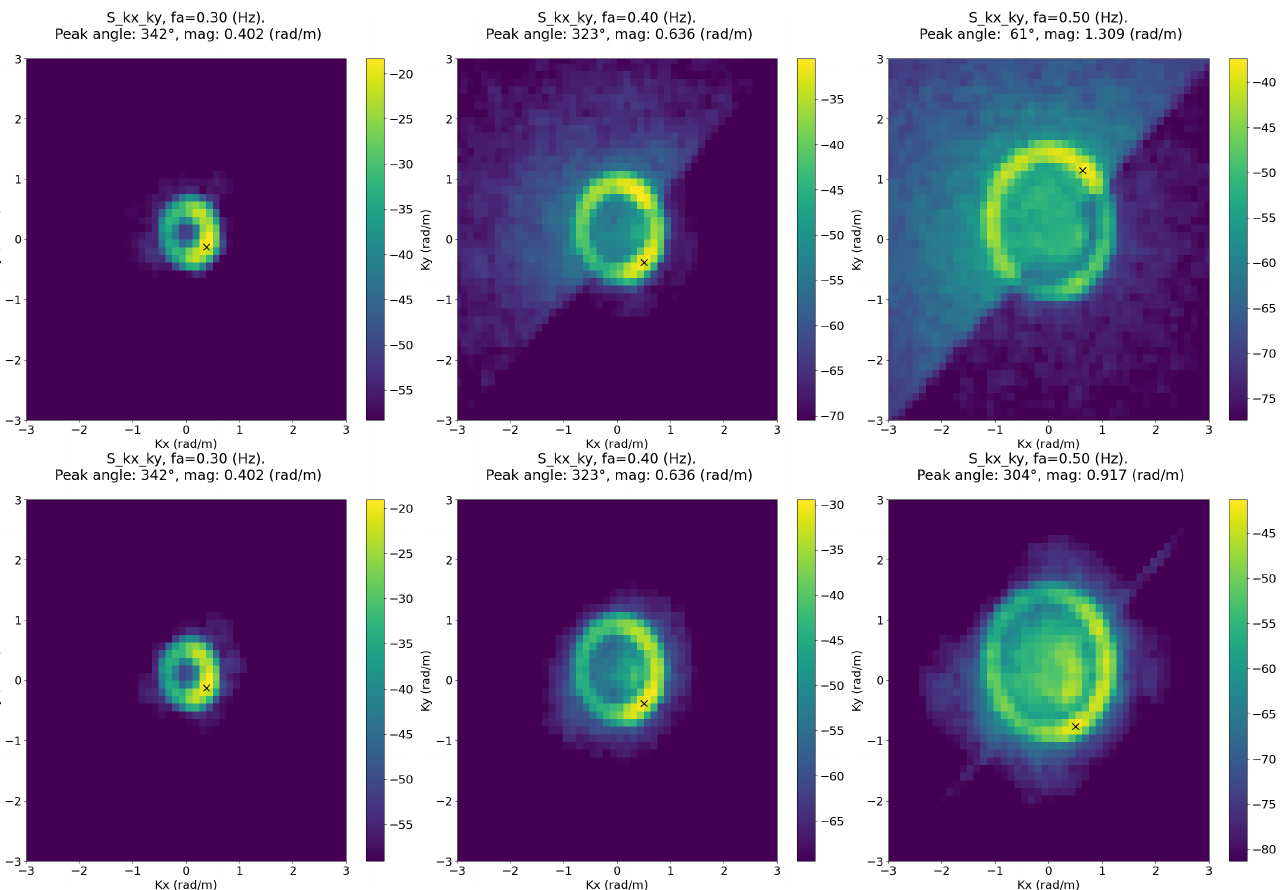
Figure 12. Directional spectra sliced from the 3D spectrum S ( K x , K y , ω a ) at ω = 0.3,0.4,0.5 Hz for record G20200916T01000. Top row : WASSfast PU mode; Bottom row : WASSfast CNN